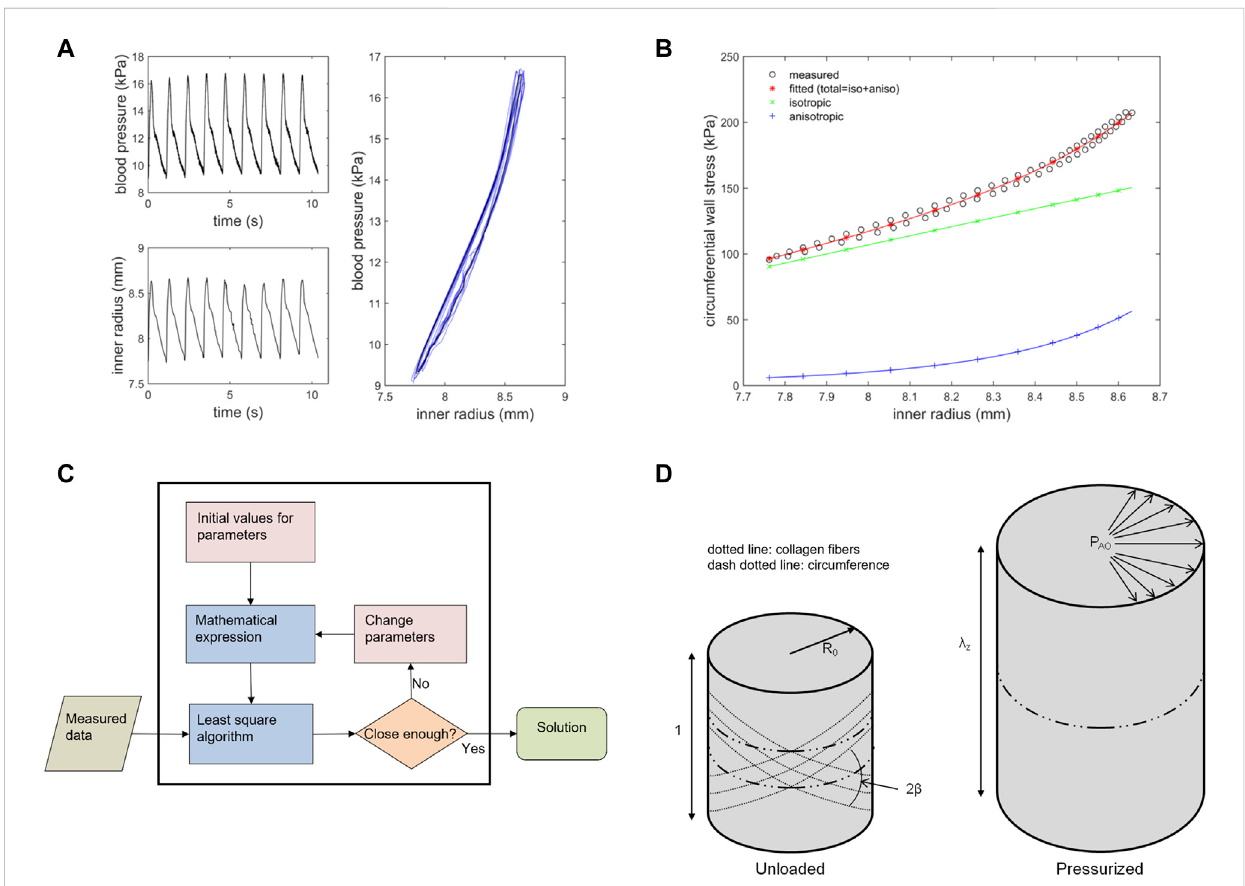
FIGURE 1 A and B illustrate measured data from the abdominal aorta and identi fi cation results from PIMMP. C and D show the identi fi cation algorithm and de fi nitions of some model parameters (A) Measured blood pressure (upper left panel) and inner radius (lower left panel) for a young male. Right panel shows the pressure-radius response (blue) and the used post processed average signal (black) (B) Wall stresses vs. inner radius in the circumferential direction for a young male. Measured data (black) with resulting fi tted curve from PIMMP representing total stress (red) which is the sum of the isotropic(green)andanisotropic(blue)components (C) Theidenti fi cationalgorithmusedtocomputethematerialparametersintheabdominalaorta,see text for description (D) An overview of how model parameters β , R 0 and λ z are de fi ned. The left cylinder represents the stress and strain free, unloaded state with unit length; the right cylinder represents the pressurized state. P AO = Pressure in the abdominal aorta, PIMMP = parameter identi fi cation method for mechanical